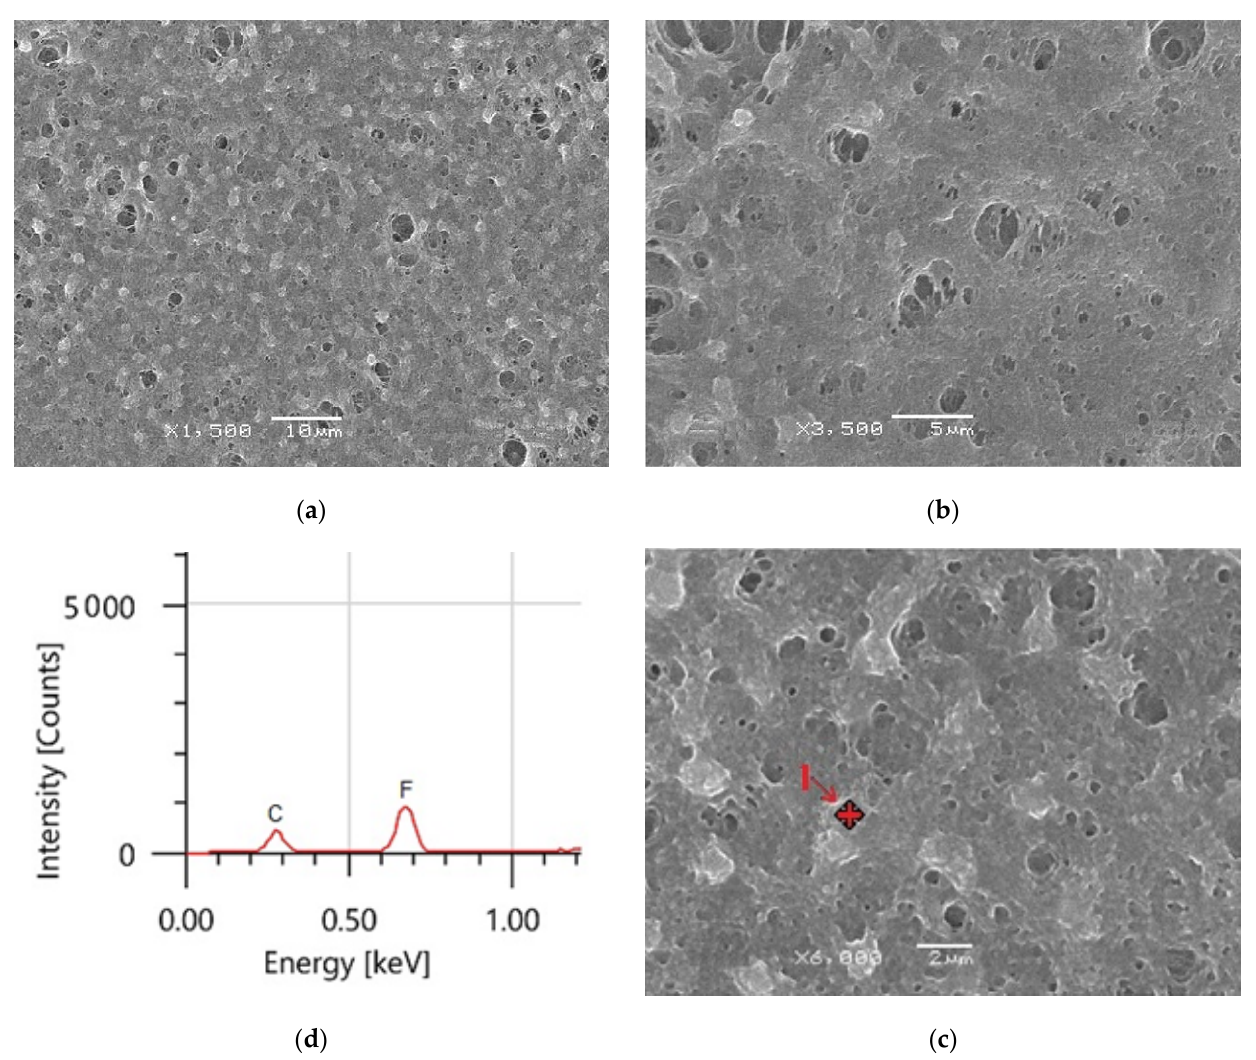
Figure 7. ( a – c ) PVDF alone membrane images with different magnifications and ( d ) EDS analysis of point 1 in ( c ).